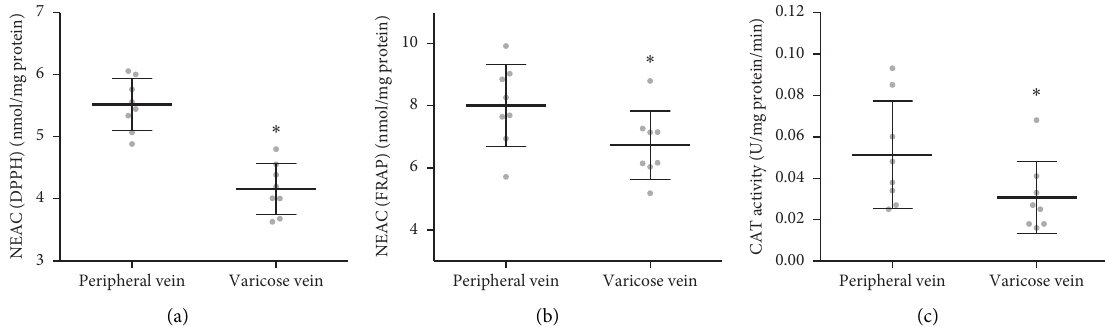
Figure 2: Total nonenzymatic antioxidant capacity in the plasma, determined by (a) DPPH and (b) FRAP methods, and catalase activity (c) in the plasma of the blood samples obtained from peripheral and varicose veins. Data are presented as mean ± range of standard deviation, n � 8. ∗ p < 0 . 05 is the significant difference.